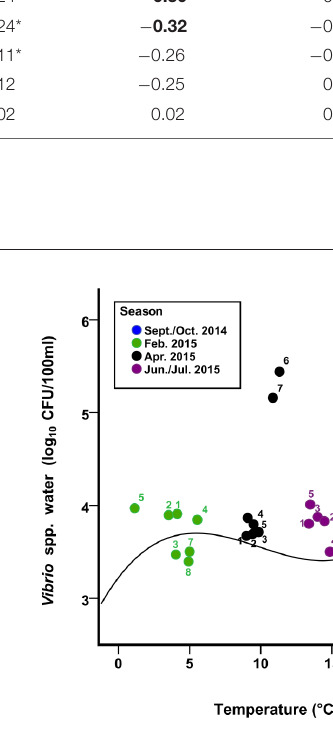
FIGURE 5 | Culturable Vibrio . Numbers represent the mean abundance and mean temperature (corresponding SD are presented in Figure 4 ) for each Conwy transect 1–5 and Ribble sites 1–2 (6) and Ribble sites 3–8 (7). Line represents cubic regression of Vibrio spp. in Conwy and Ribble water with water temperature, p -value highlights significance of fit to